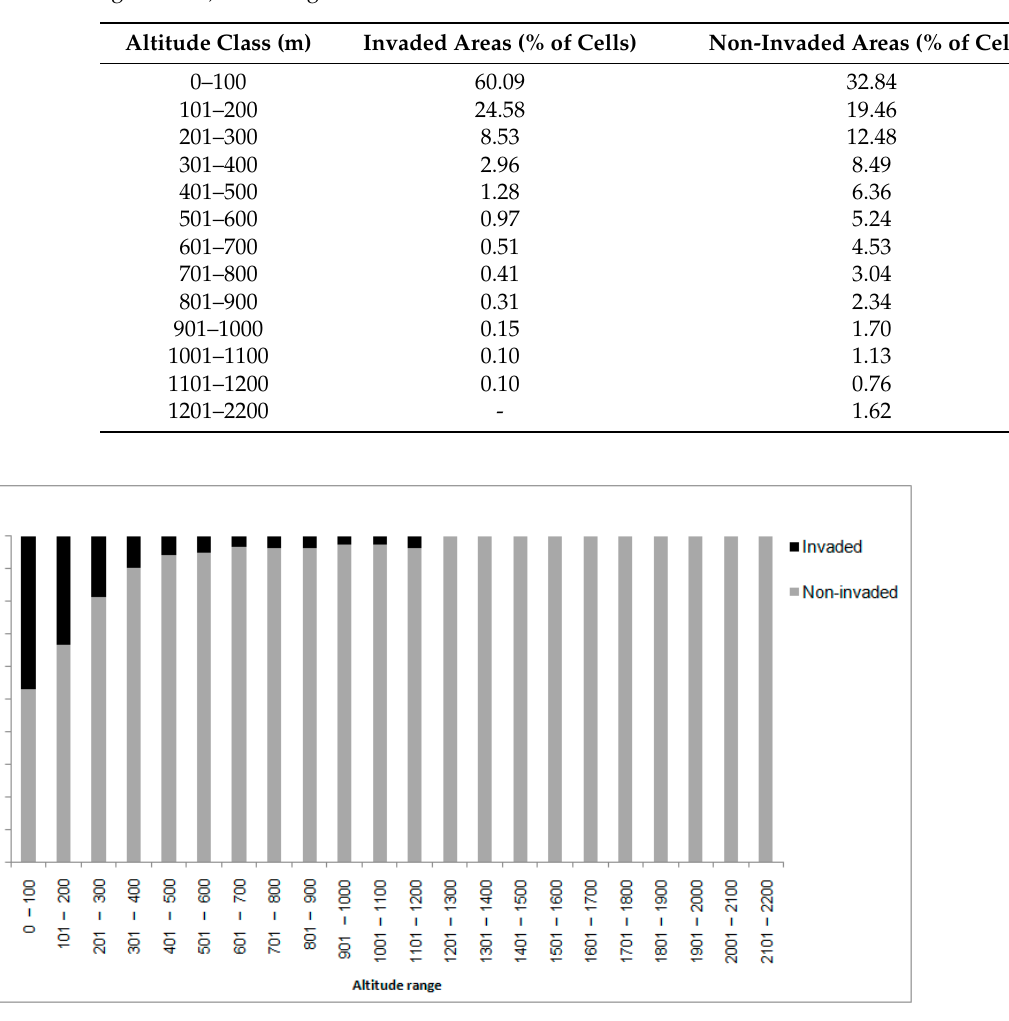
Table 1. Distribution of noninvaded and invaded areas by Solanum elaeagnifolium in Greece (percentage of cells) according to altitude classes.